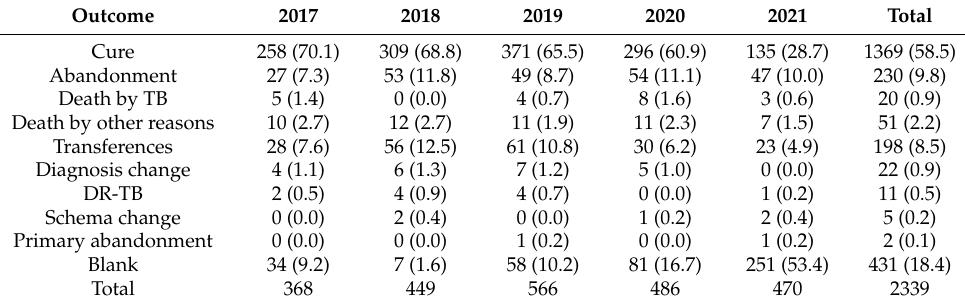
Table 2. Closure situation of tuberculosis cases in the municipality of Ananindeua-Pa from 2017 to 2021 ( n = 2339).